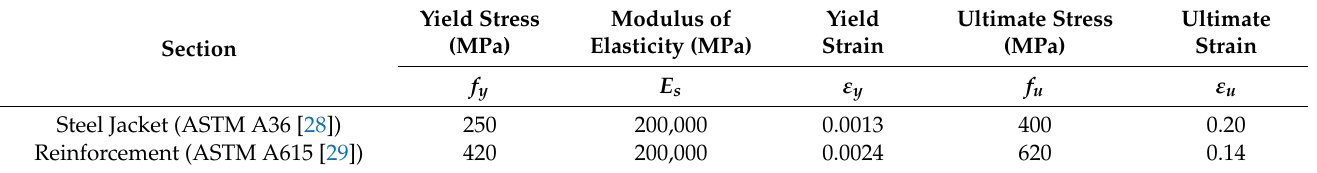
Table 5. Material properties of steel jacket and